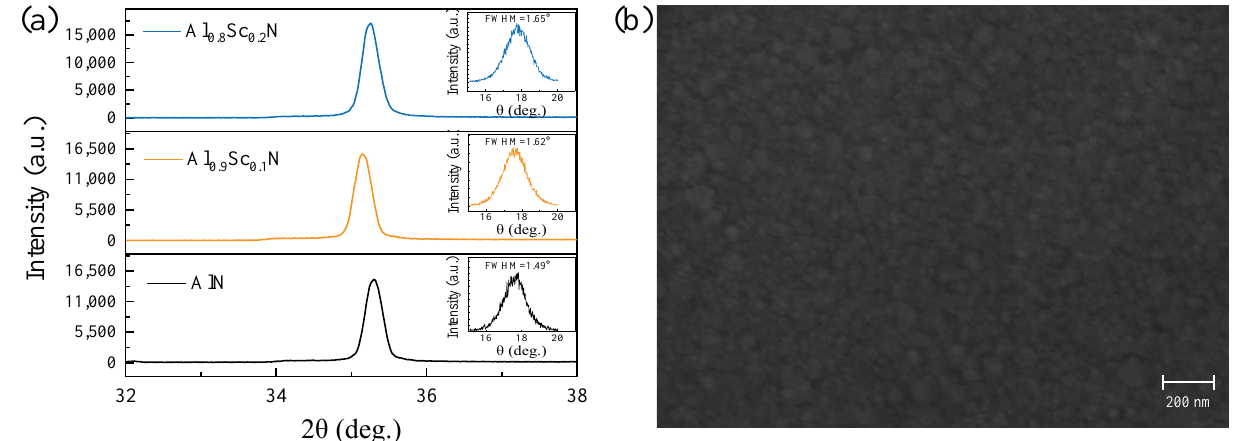
Figure 4. XRD results and morphology of piezoelectric materials. ( a ) XRD results of 1 µ m-thick AlN, Al 0.9 Sc 0.1 N, and Al 0.8 Sc 0.2 N films, respectively. ( b ) Morphology of 1 µ m-thick Al 0.8 Sc 0.2 N film. In our work, for the fabricated FBARs, three different piezoelectric layers were de- posited, including 1 µ m-thick pure AlN, 1 µ m-thick composite piezoelectric layer compris- ing 500 nm-thick AlN and 500 nm-thick Al 0.9 Sc 0.1 N, and 1 µ m-thick composite piezoelectric layer comprising 500 nm-thick AlN and 500 nm-thick Al 0.8 Sc 0.2 N. Figure 5a shows the cross-sectional view of FBAR based on 1 µ m-thick AlN/Al 0.9 Sc 0.1 N composite film,